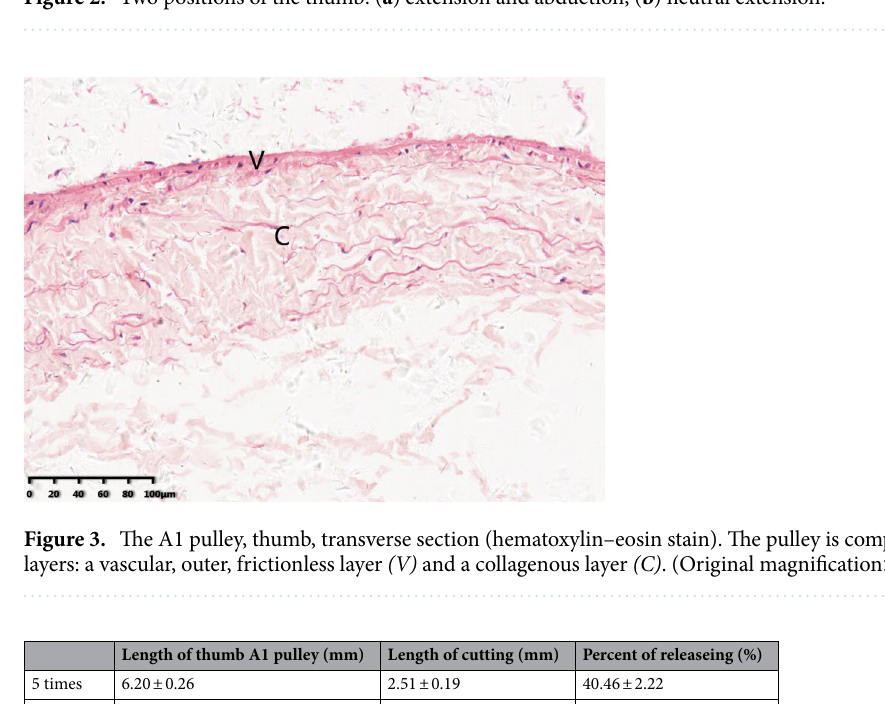
Figure 2. Two positions of the thumb: ( a ) extension and abduction; ( b ) neutral extension.